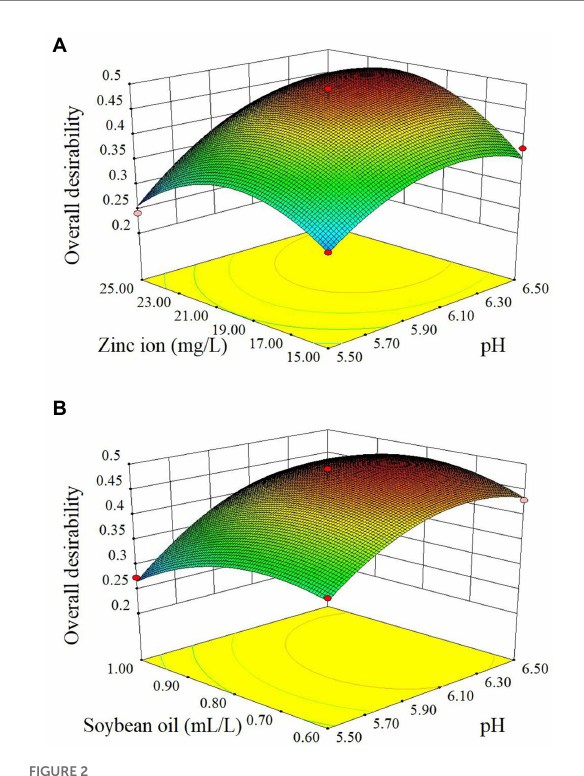
FIGURE 2 The effect of factors on overall desirability with response